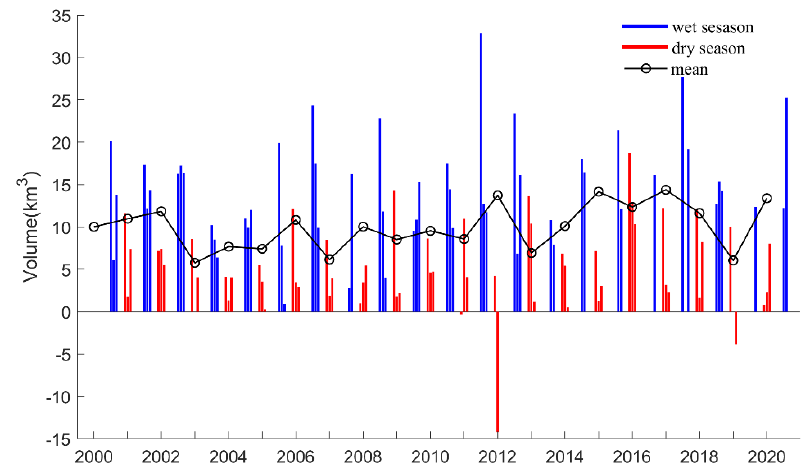
Figure 11. Water exchange between Poyang Lake and Yangtze River on a monthly scale during 2000–2020. The red bars indicate the water flows in the dry seasons, the blue bars indicate those in the wet seasons, and the circle-line symbol indicates mean value of the wet and dry seasons.